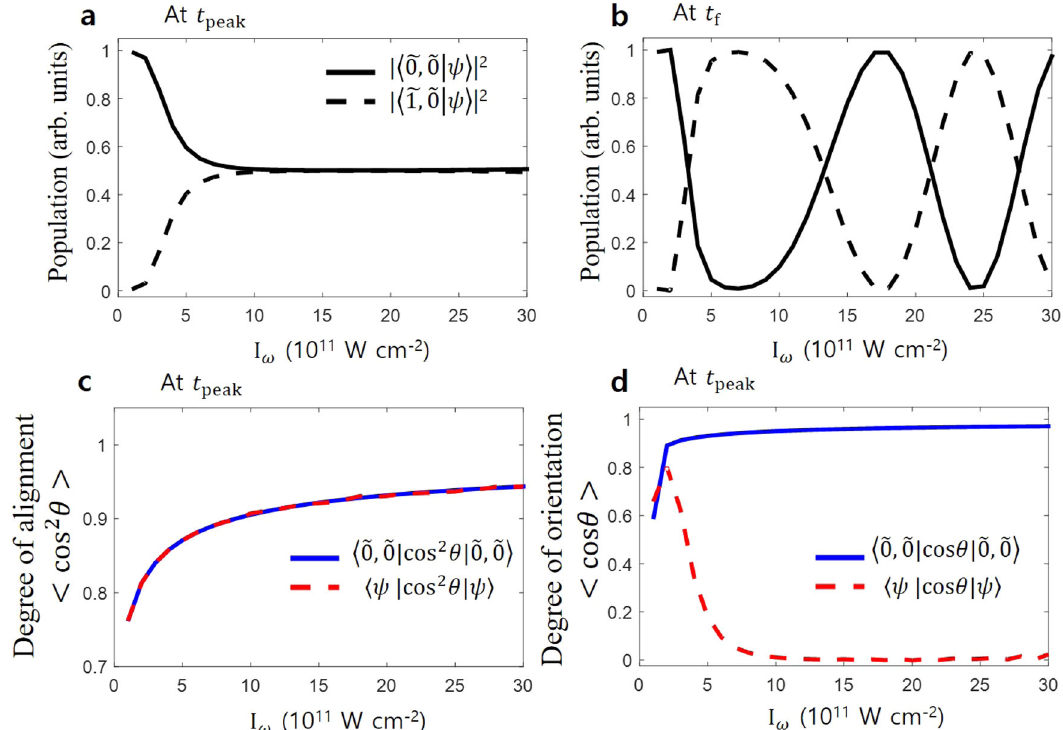
(cid:1) (cid:3) (cid:1) (dashed line) state (cid:1) (cid:3) (cid:1) (red-dashed line) obtained by